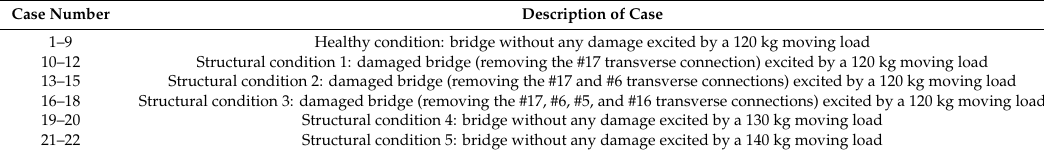
Table 1. Description of all cases for the experimental example.